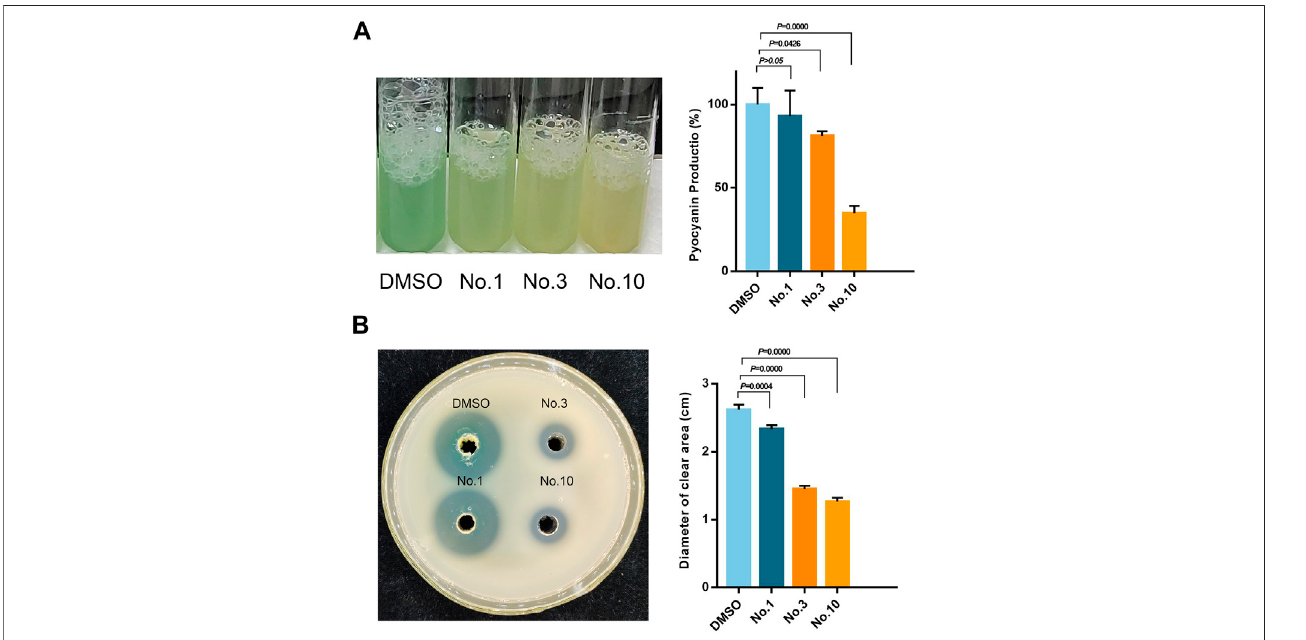
FIGURE 6 | Inhibitory effect of compound no.3 and compound no.10 on (A) pyocyanin and (B) elastase productions of P. aeruginosa PAO1.